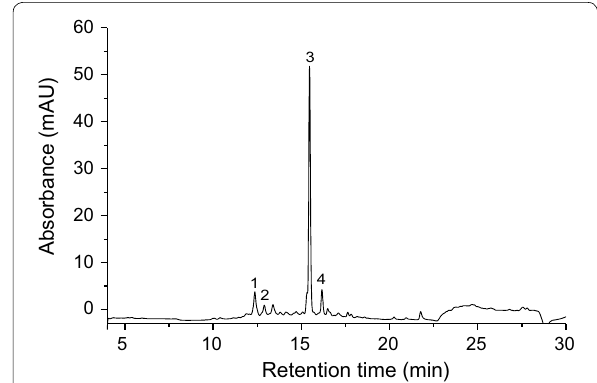
Fig. 3 HPLC chromatogram (detected wavelength at 340 nm) of R. oligosporus fermented apricot pomace (9th day of SSF):